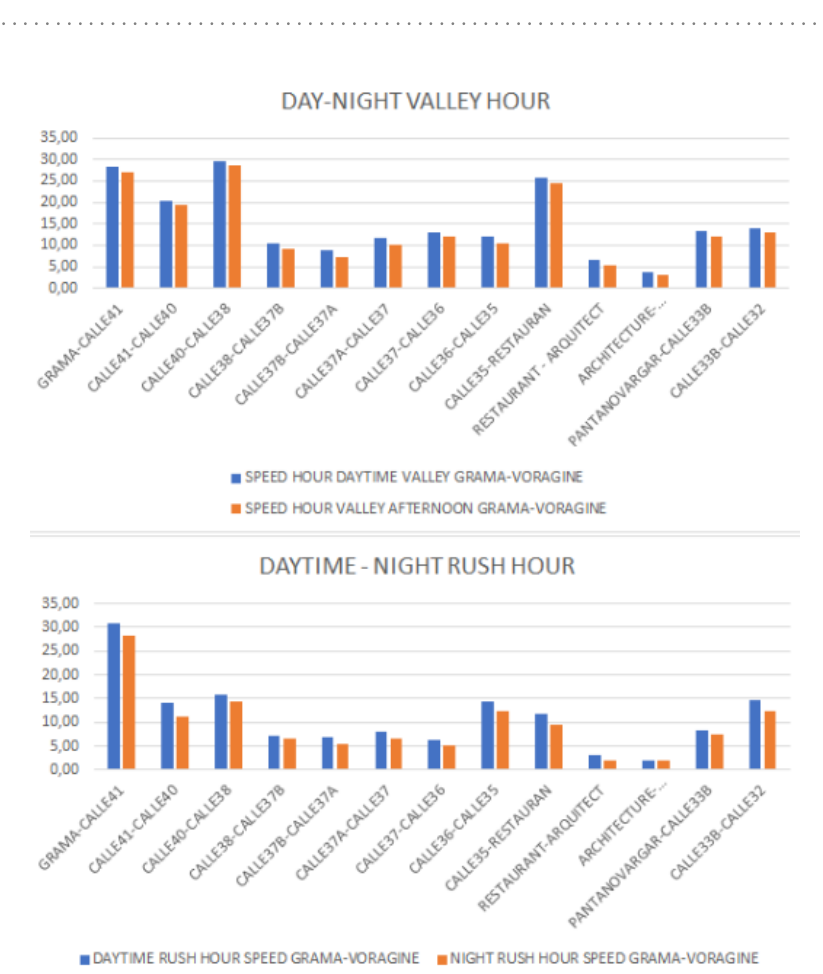
Figure 4: Day/night velocities for section 1 of the Avenue under study. The mean velocity is around 15